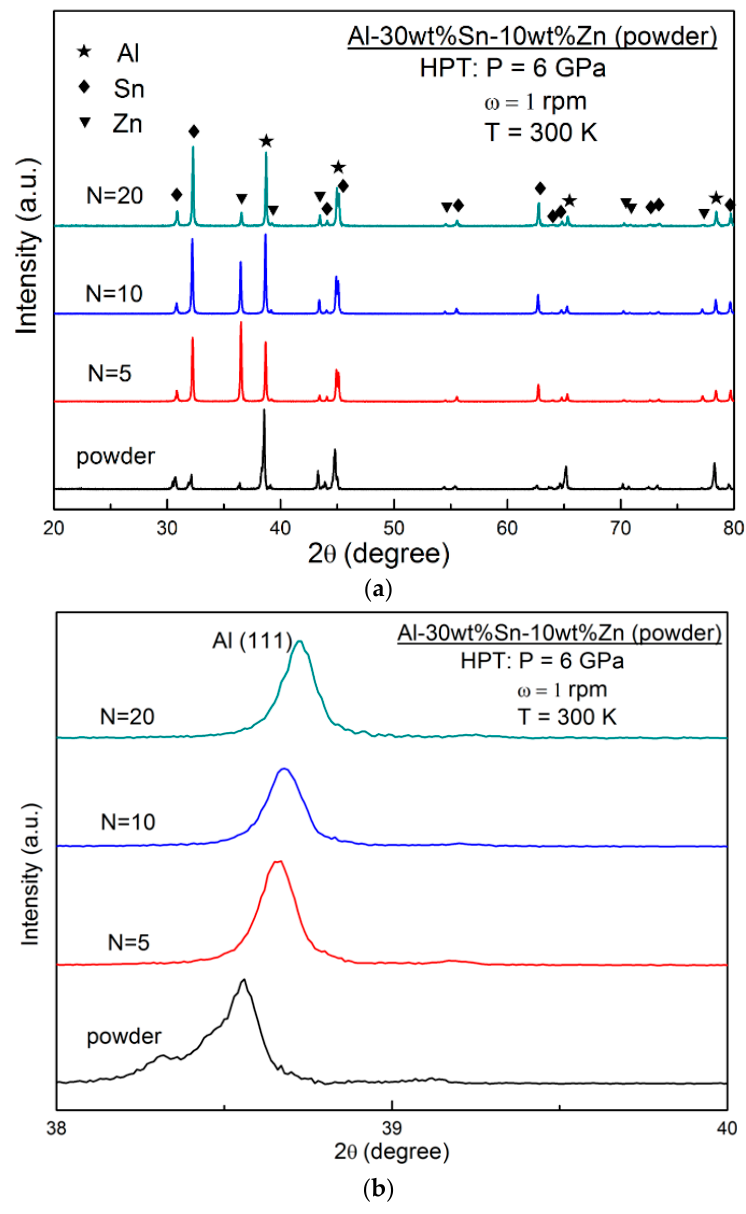
Figure 7. XRD profiles for ( a ) Al-30wt %Sn-10wt %Zn powders before HPT processing and after HPT processing for N = 5, 10, and 20 and ( b ) magnified view for Al (111) peak.